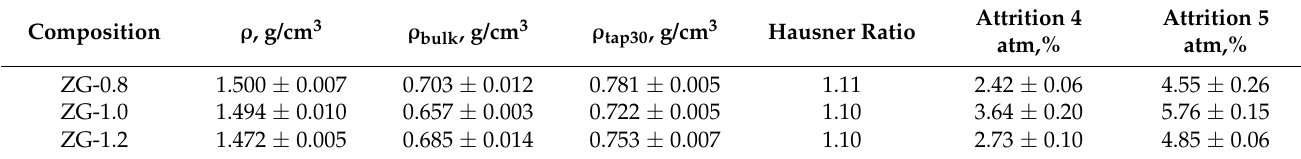
Table 6. Densities and attrition of produced